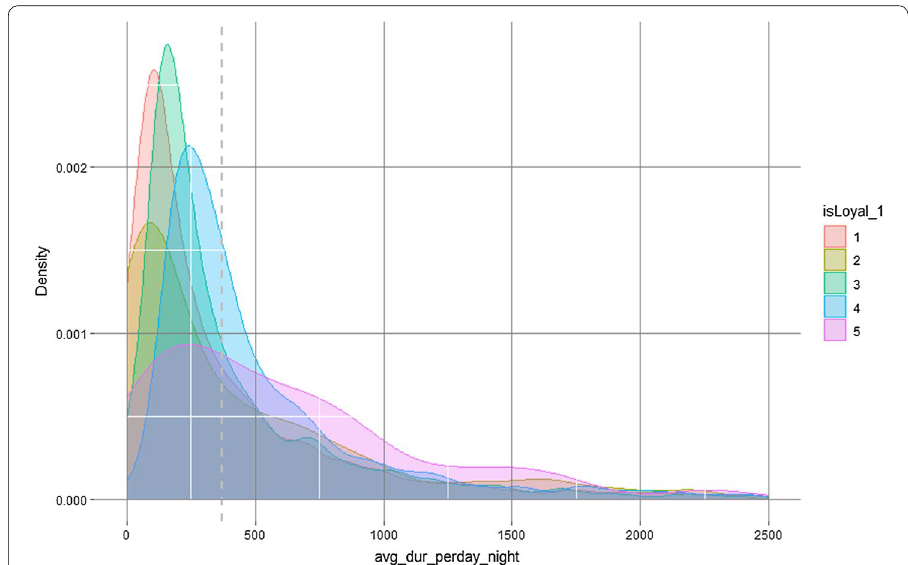
Fig. 6 Mass distribution for “Avg dur perday night”